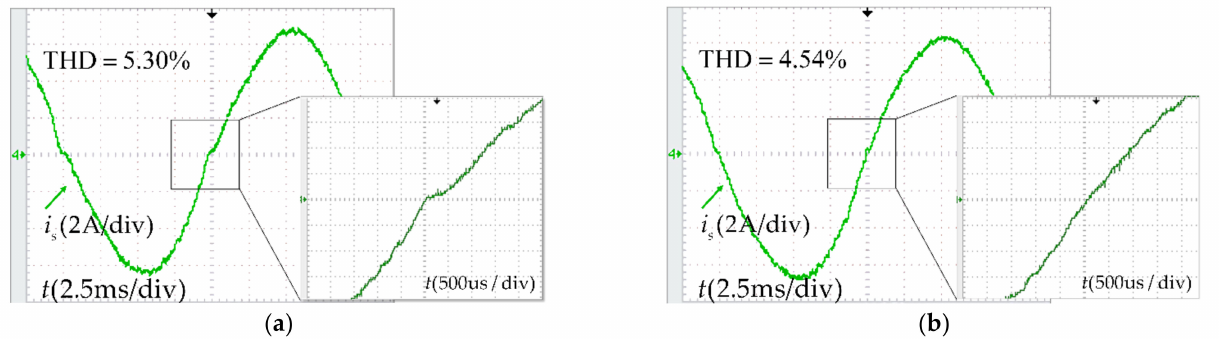
Figure 20. The current waveform when the dead time is 4 µ s. ( a ) No compensation ( b ) With compensation.